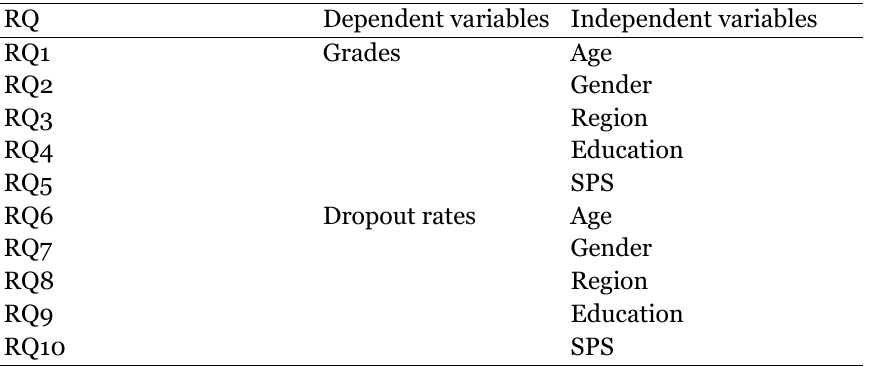
Research Questions (RQ) and